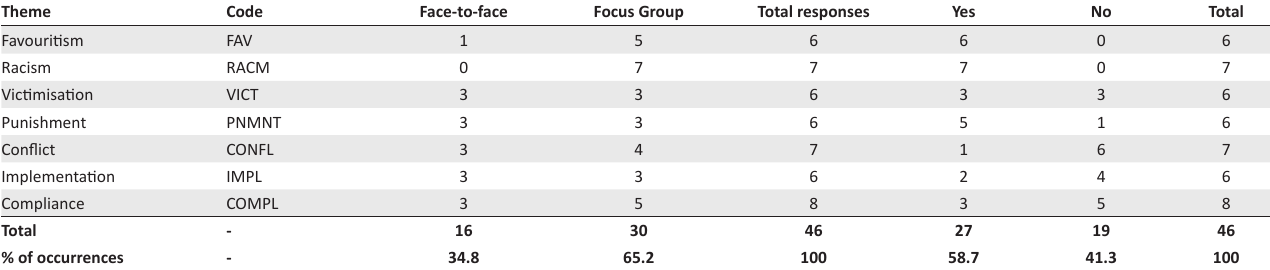
TABLE 9: Quantified qualitative outcomes of themes for Cluster 4: Emerging new